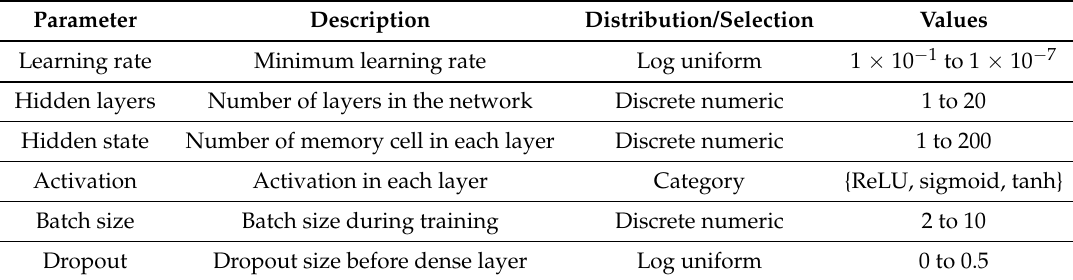
Table 1. Parameters used in optimum network search for novel coronavirus (COVID-19). Parameter Description Distribution/Selection Values Learning rate Minimum learning rate Log uniform Hidden layers Number of layers in the network Discrete numeric 1 to 20 Hidden state Number of memory cell in each layer Discrete numeric 1 to 200 Activation Activation in each layer Category {ReLU, sigmoid, tanh} Batch size Batch size during training Discrete numeric Dropout Dropout size before dense